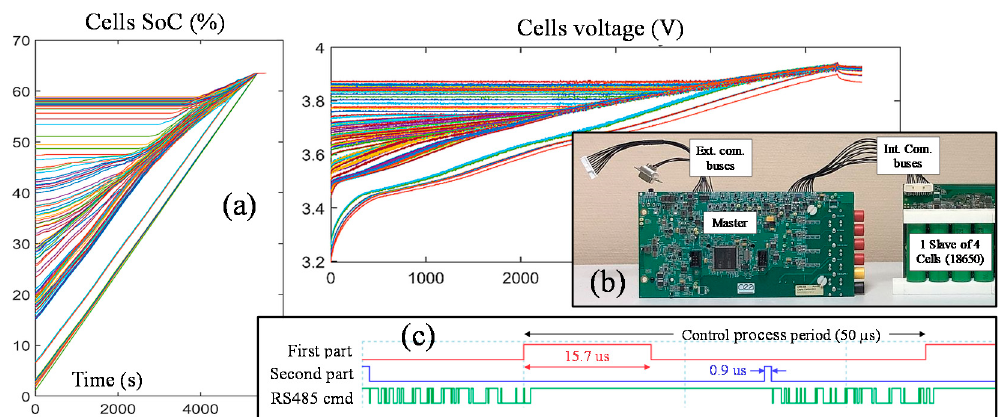
Figure 8. Cells balancing of HF SRB on direct charge with electrical grid ( a ); the master and one slave unit ( b ); and control process period ( c ).